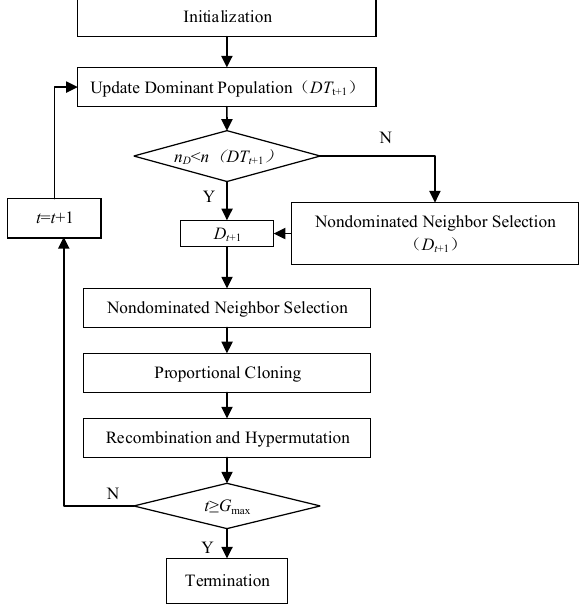
Figure 11. The flow chart of NNIA.